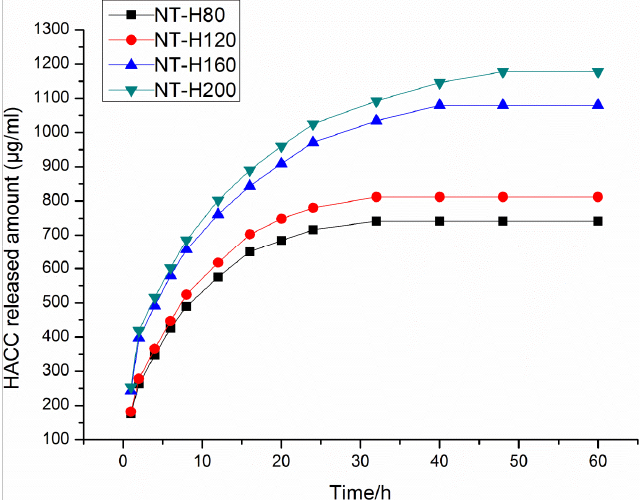
Figure 2. Cumulative HACC release profiles from HACC loaded nanotubes with different diameters, expressed in μ g/mL. Table 1. The initial and total release of HACC in 60 h.